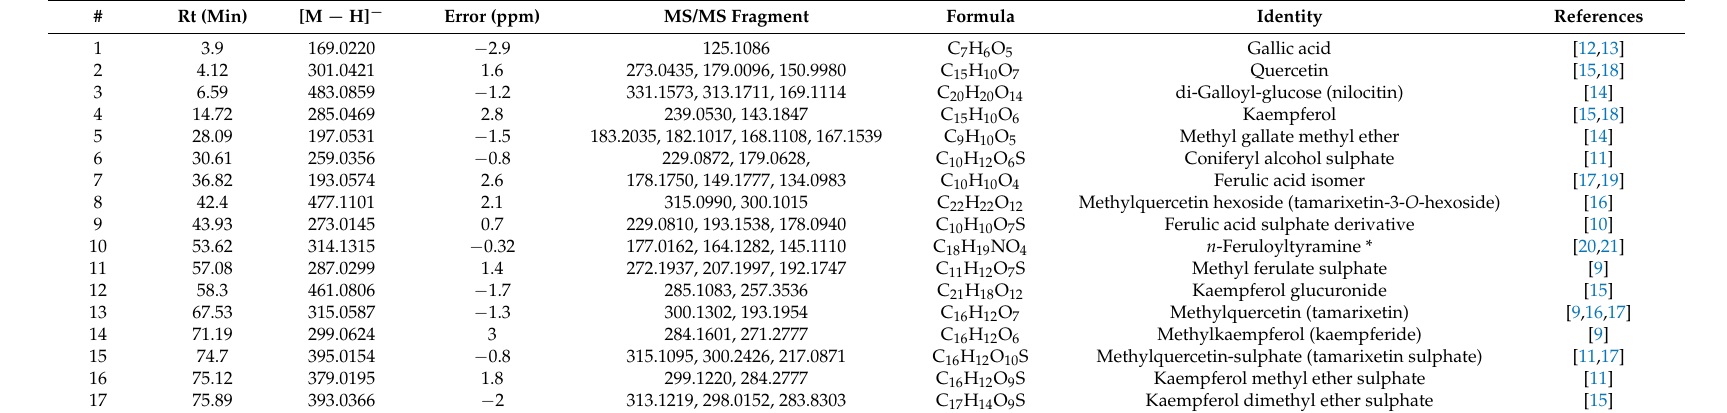
Table 1. Characterization of metabolites from ETN by HPLC-MS/MS in negative ion mode.